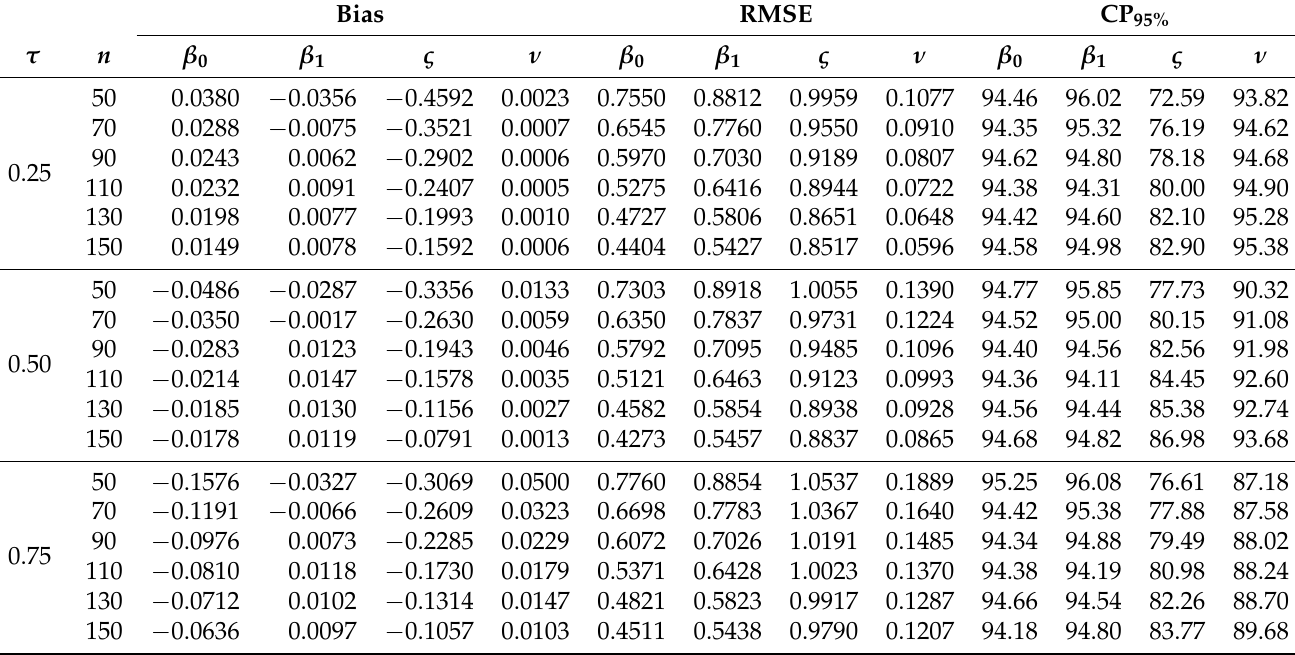
Table 5. Empirical RMSE, bias, and 95% CP (true values: β 0 = 0.50, β 1 = 0.50, ς = 1.50, and ν = 0.50) of the ML estimator for the indicated parameter with simulated data.